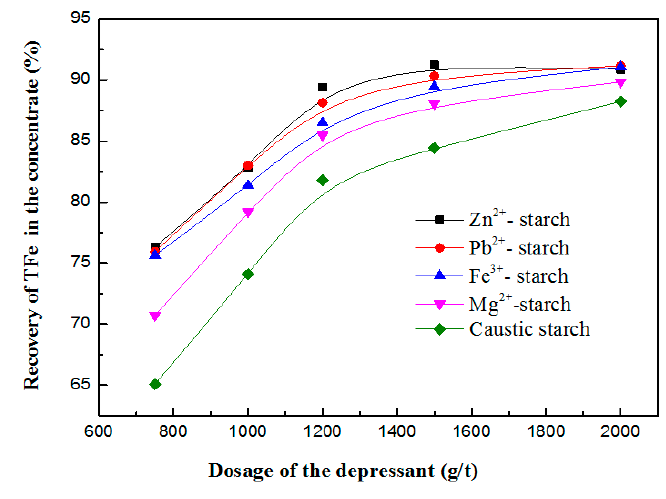
Figure 5. Effect of depressant dosage on the floatation recovery at pH 7.5 (DDA 625 g/t). Table 2. Effect of MSC on the flotation performance (depressant 1200 g/t, DDA 625 g/t, pH 7.5). Depressant Mass Recovery/% Grade Total Fe/% Recovery of Total Fe/% Caustic starch